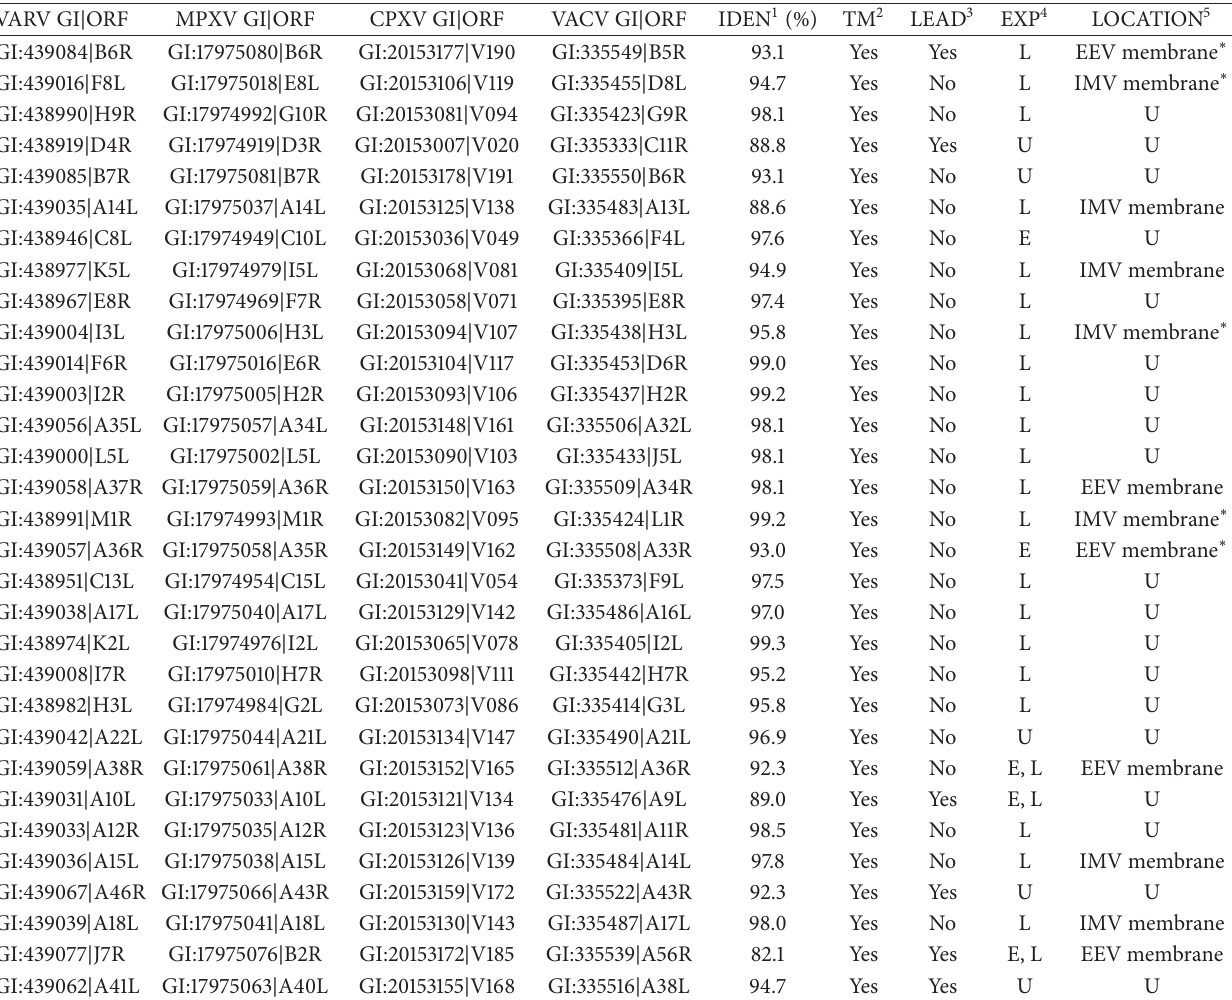
Table 3: Shared orthopoxvirus proteins with transmembrane and/or leader